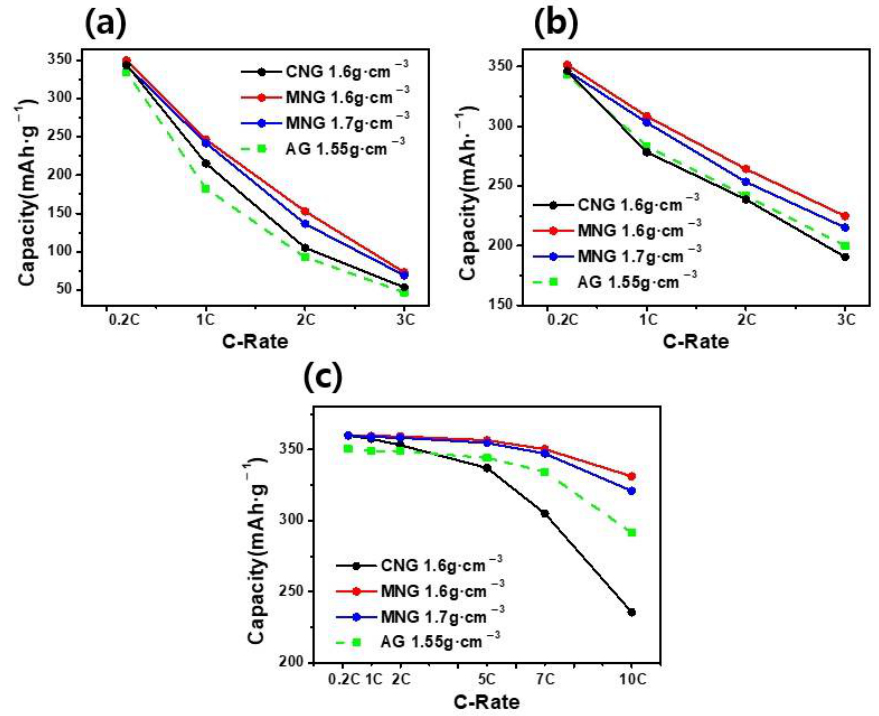
Figure 8. Comparison of ( a ) charge in constant current (CC) mode, ( b ) charge in constant current– constant voltage (CC-CV) Mode, and ( c ) discharge rate performance of CNG and MNG and AG.